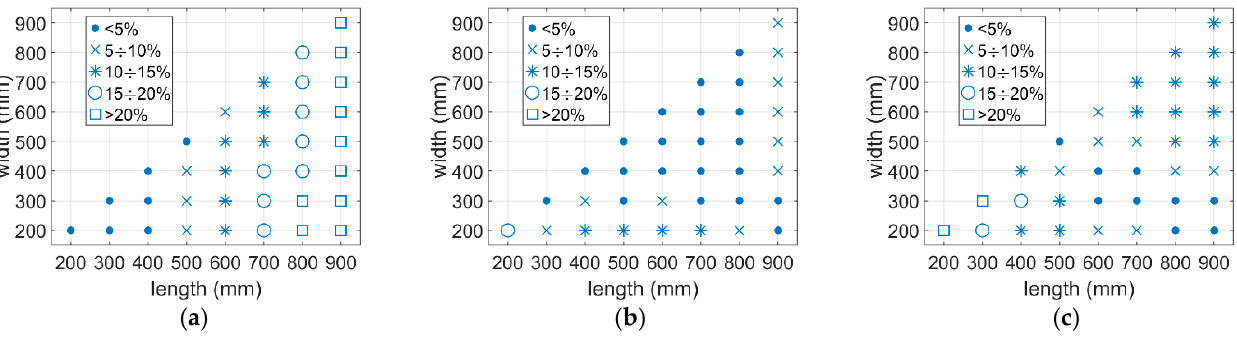
Figure 14. The prediction error distribution obtained using the analytical model for the first extreme: ( a ) H = 200 mm; ( b ) H = 500 mm; ( c ) H = 800 mm.